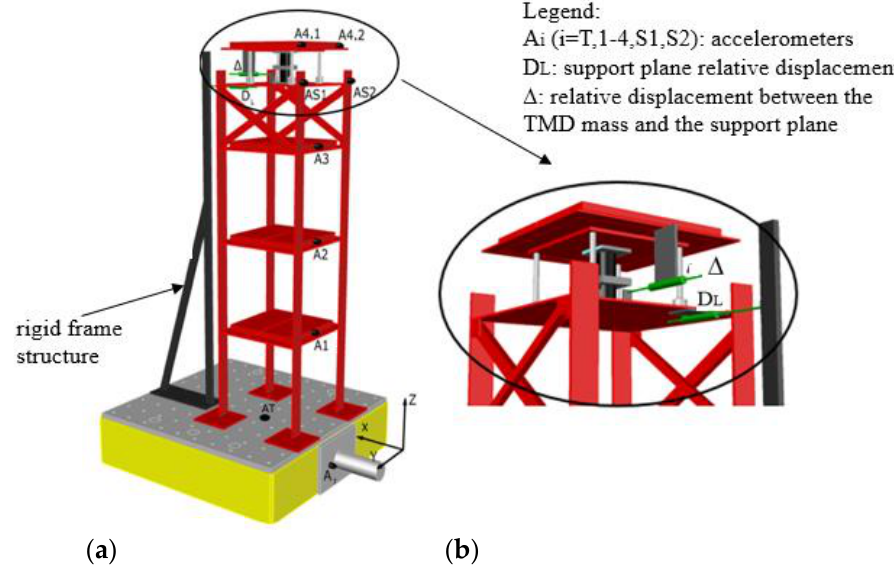
Figure 7. Position of the measurement instruments on the FTMD configuration: ( a ) 3-story structure with non-conventional TMD, ( b ) detail of the TMD.